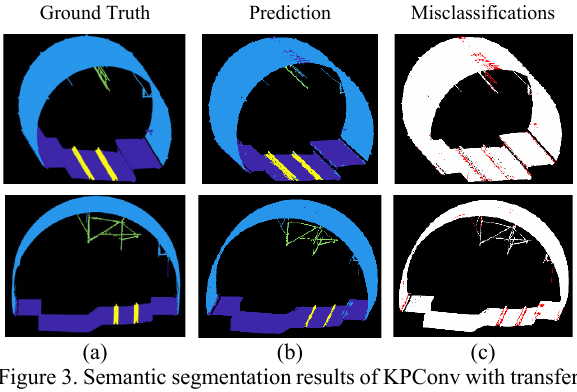
Figure 3. Semantic segmentation results of KPConv with transfer learning for tunnel A (top row) and B (bottom row). (a) Ground truth. (b) Prediction. (c) Misclassified points (in red).